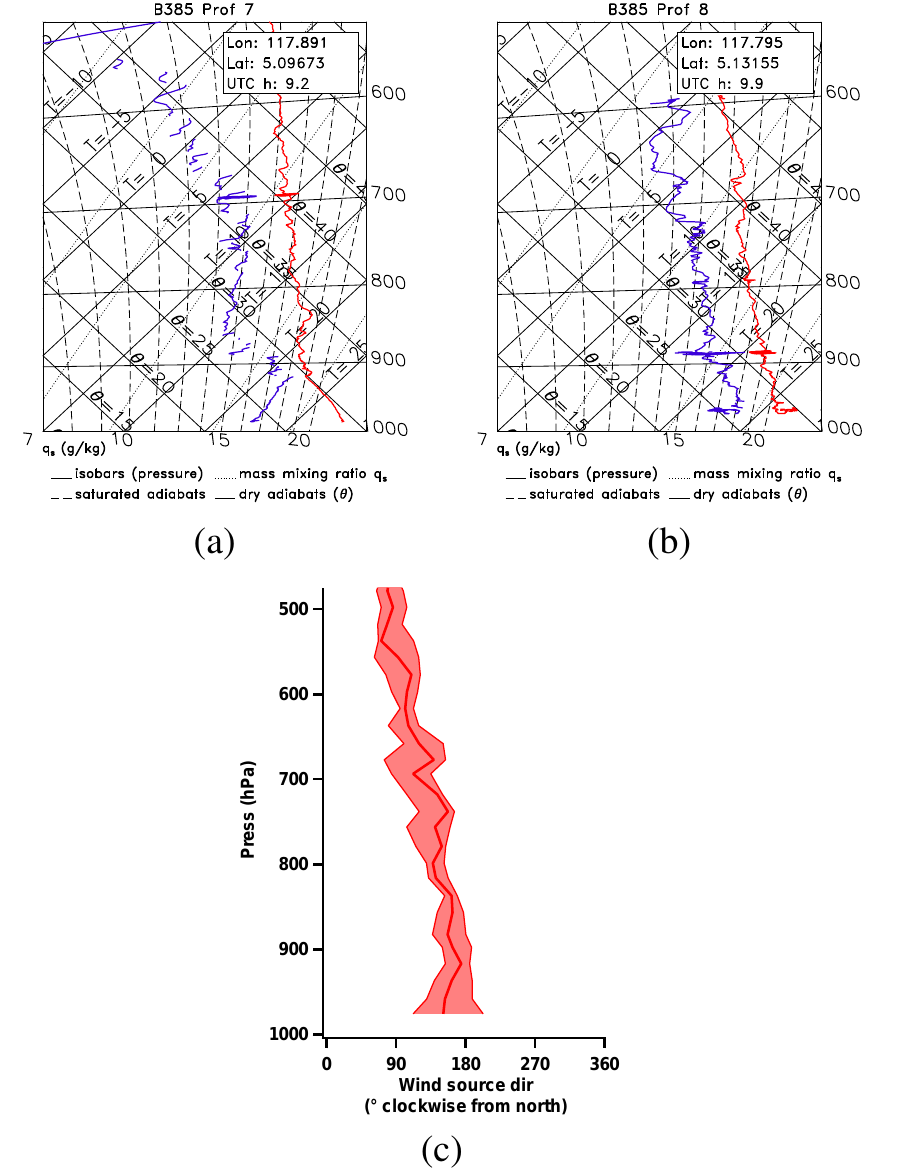
Fig. 5. (a) A typical tephigram performed on 11 July 2008, 17:11 during the ITC-dominated regime, and (b) on during the MCS-dominated regime, both over East Sabah. (c) The average wind vector profile over East Sabah during both regimes. change from southerly to easterly winds above the surface mixed layer, sometimes with strong shear but usually with a gradual transition (Fig. 5c). Individual profiles are presented in the